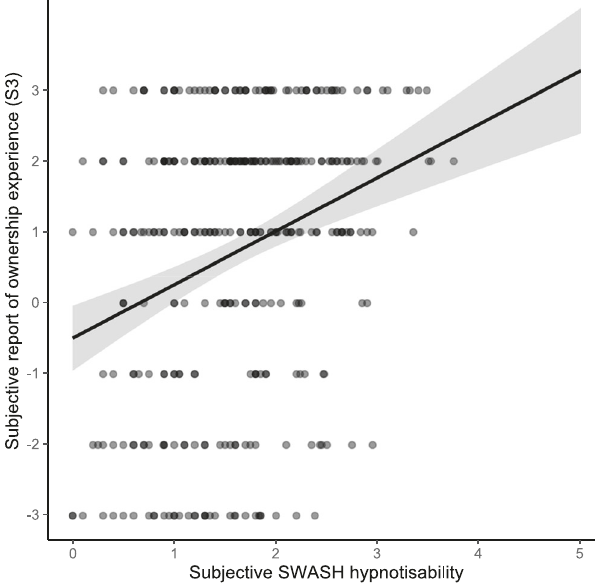
Fig. 1 Agreement with the statement “ I felt as if the rubber hand were my hand ” (S3; ‘ ownership ’ ) on hypnotisability. b = 0.76 Likert units subjective response per SWASH unit, SE = 0.13, t = 5.79, P < 0.001, 95% CI [0.50, 1.01] B H(0,1.4) = 4.2 × 10 6 (B calculated as in Lush et al 1 .). r s = 0.27, 95% CI [0.17, 0.36]. Source data are provided as a Source Data fi